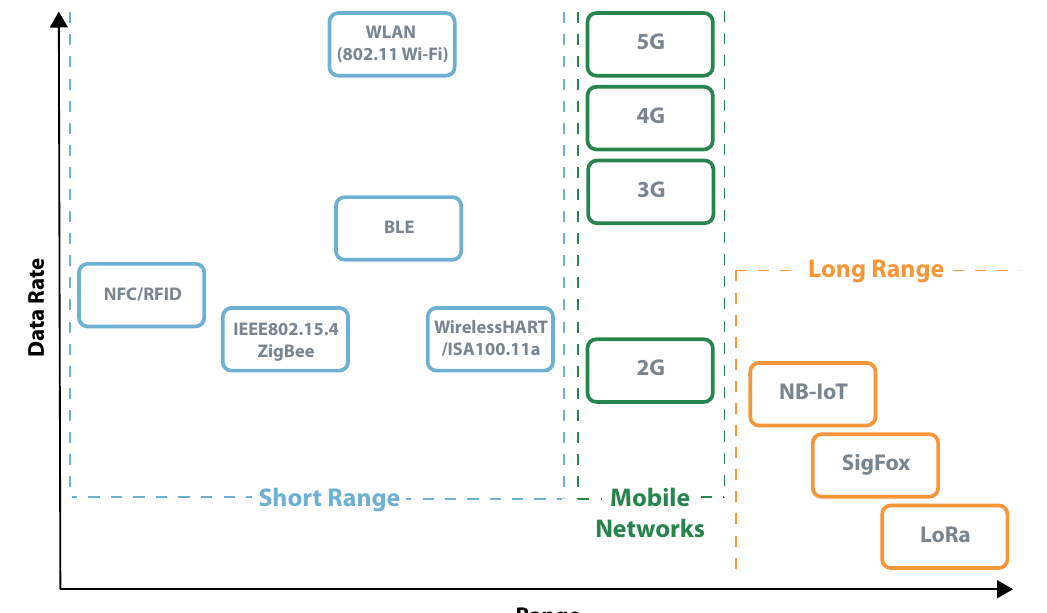
Figure 19. Data rate vs. Range—active radio communication